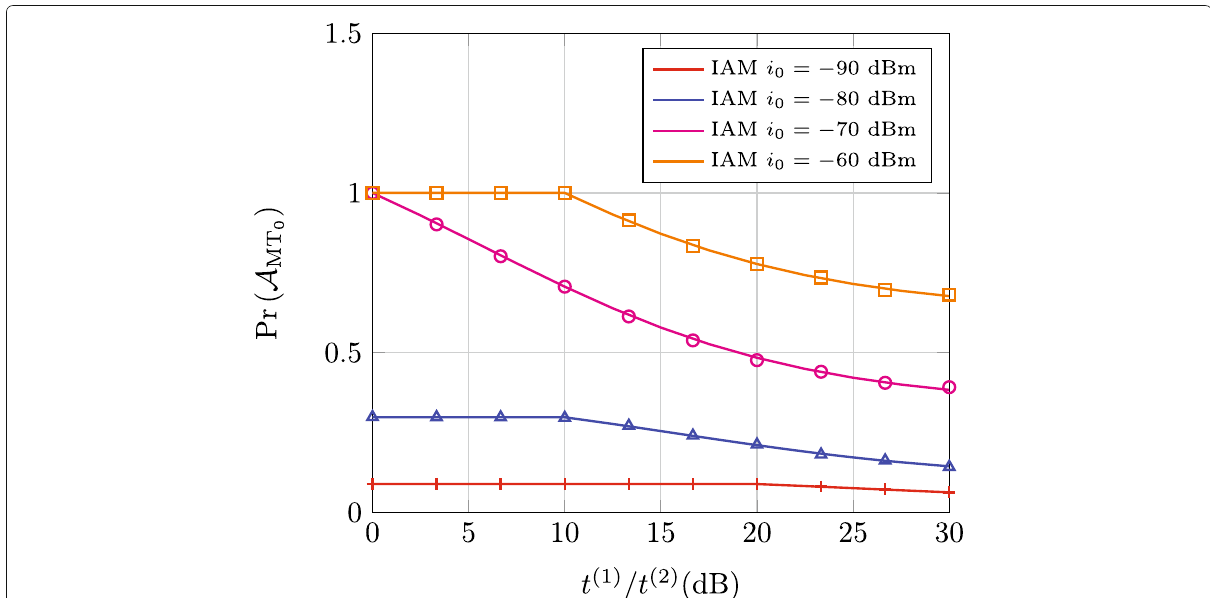
Fig. 11 Probability the typical MT is active as a function of t ( 1 ) / t ( 2 ) for IUFPC ( i 0 → ∞ ) and IAM with i 0 = {− 90, − 80, − 70, − 60 } dBm. p max → ∞ for both schemes